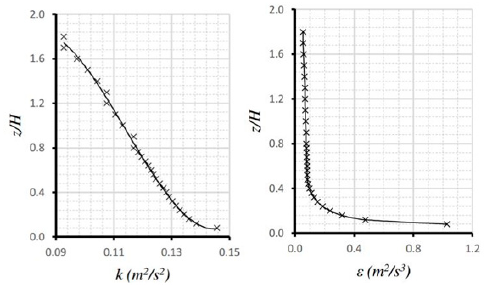
Figure 4. Turbulent kinetic energy and dissipation for CFD model validation.